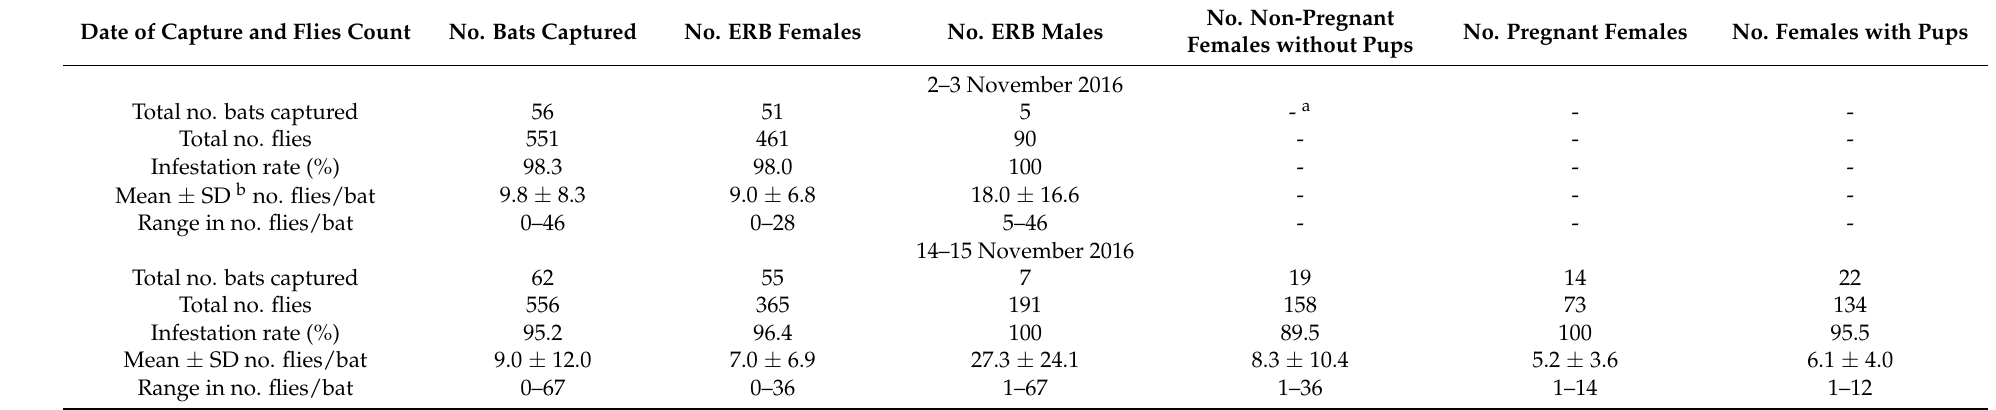
Table 1. Infestation rate of Egyptian rousette bats by bat flies at Matlapitsi Cave estimated on two different collection dates in November 2016, South Africa. Date of Capture and Flies